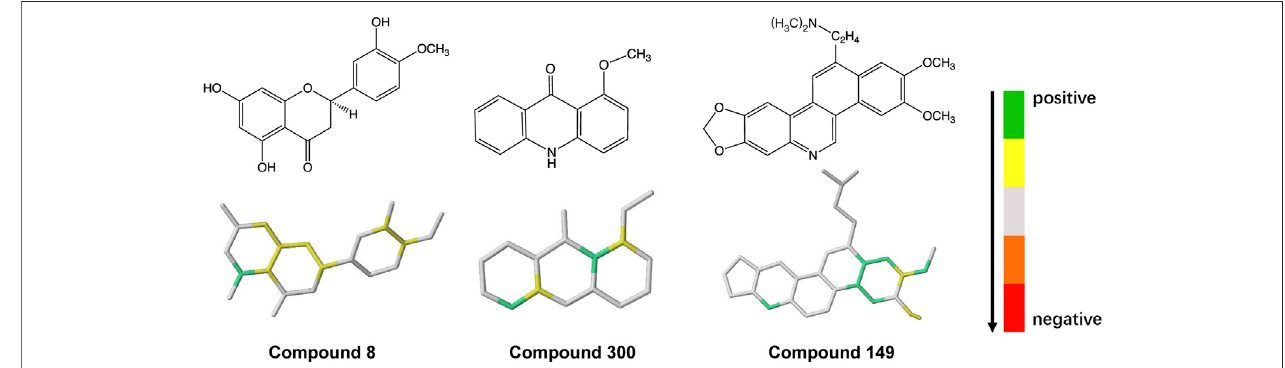
FIGURE 3 | Mapping of atomic contributions in the fragments of ABCG2 inhibitors with diverse scaffolds.